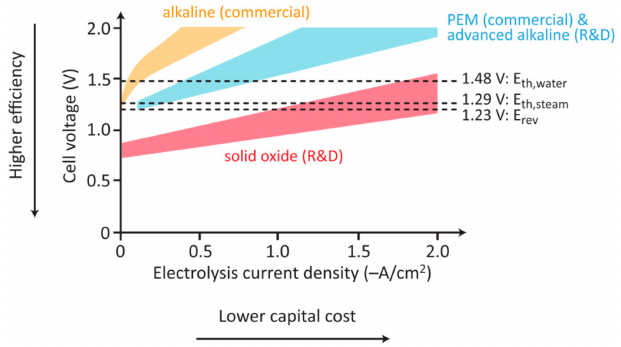
Figure 1. Comparison between alkaline, polymer electrolyzer membrane (PEM), and solid oxide electrolyzers in terms of voltage vs. current density